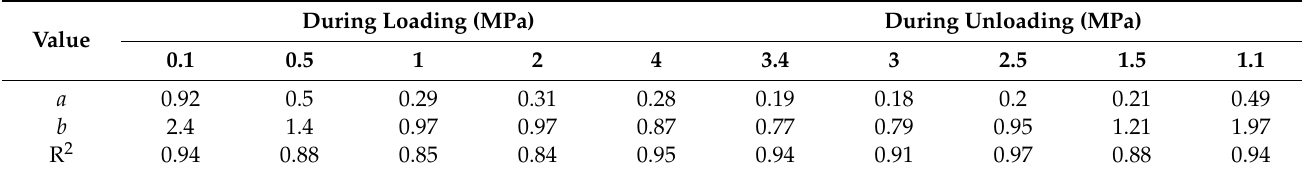
Table 3. a and b under different vertical stress for